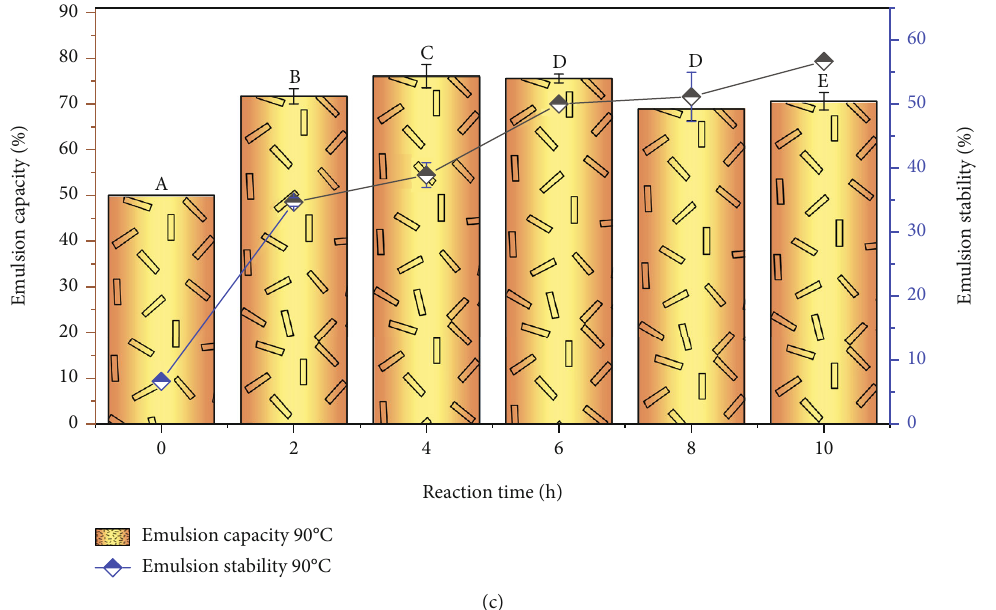
Figure 7: Emulsion capacity and stability of BSFL-Glu conjugates: (a) 50 ° C, (b) 70 ° C, and (c) 90 ° C. Values are mean ± standard deviation ; means with di ff erent superscript are signi fi cantly di ff erent at the same heating